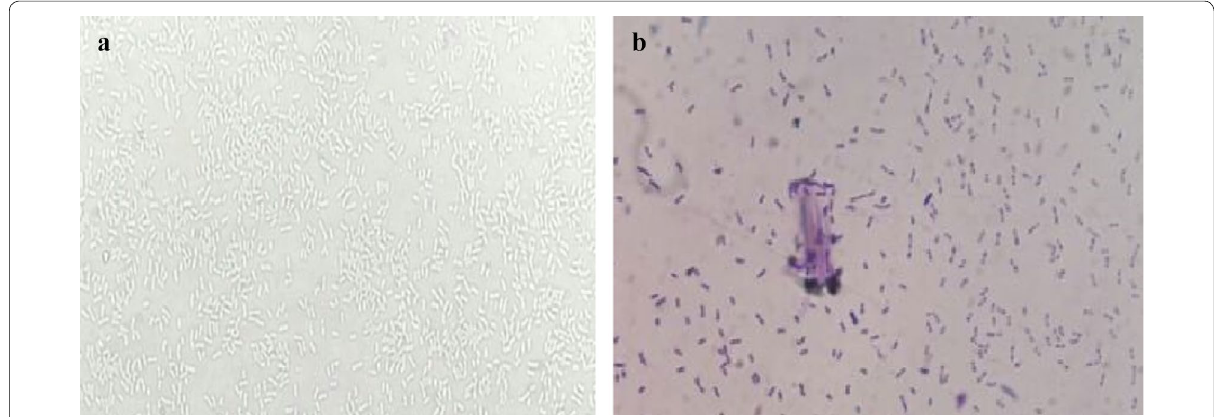
Fig. 1 Microscope picture of the EB-06 strain: a unstained bacterial morphology (10